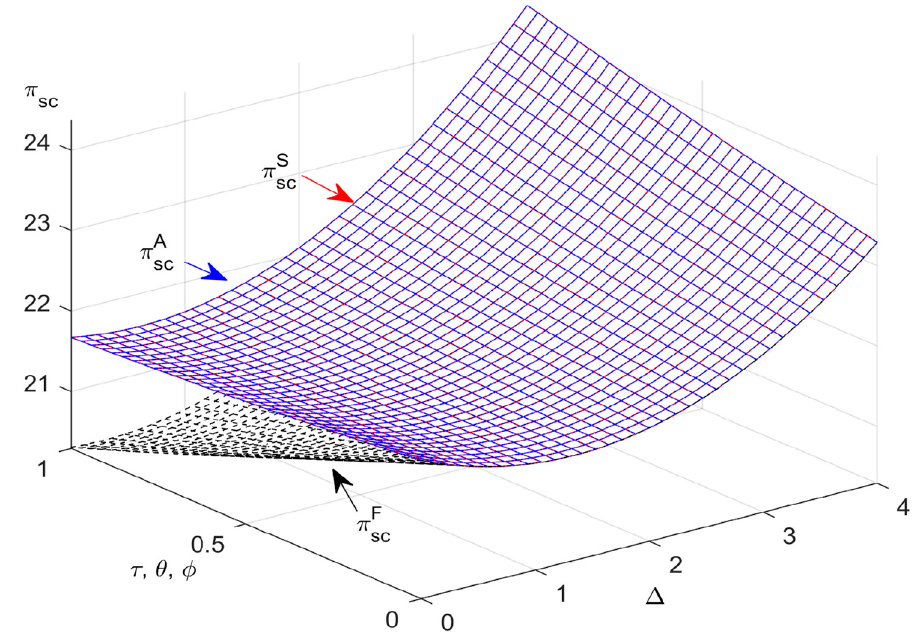
Figure 5. Comparison of the supply chain profit under the retailer’s different CSR practices.